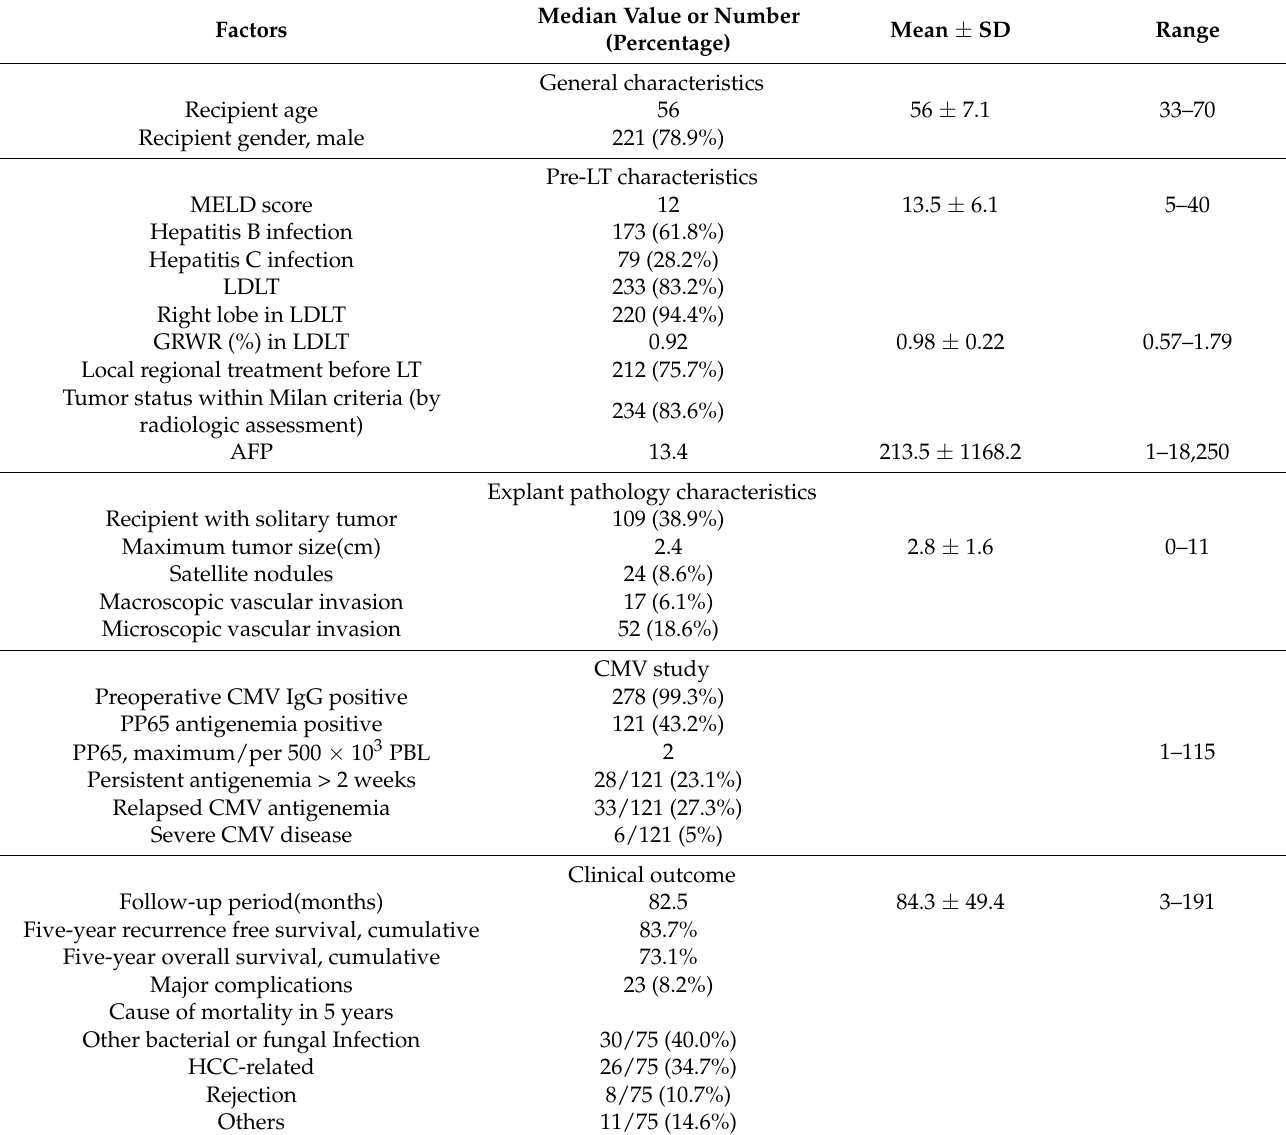
Table 1. Demographic characteristics of 280 HCC patients underwent